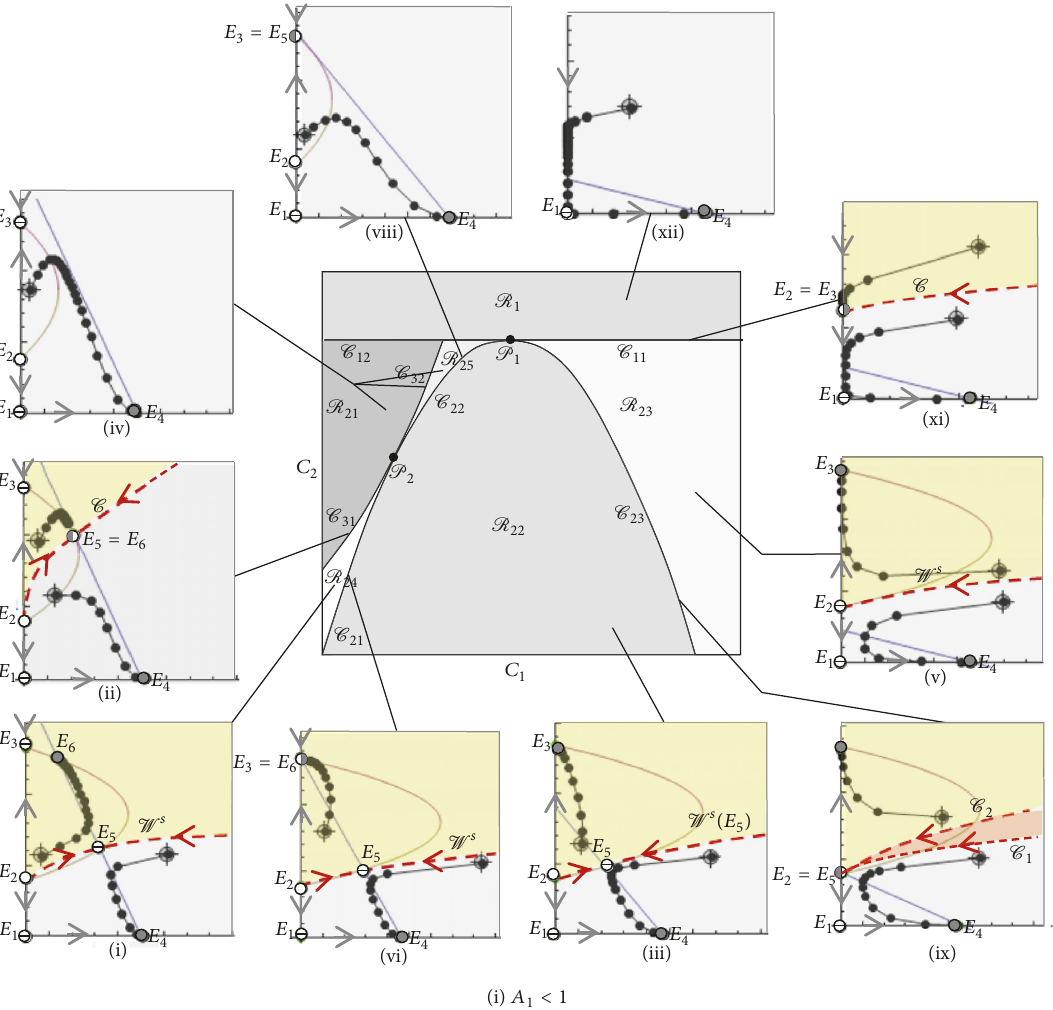
Figure 3: Parameter regions in terms of parameters 𝐶 1 and 𝐶 2 and corresponding dynamic scenarios for system (1) if 𝐴 1 < 1.